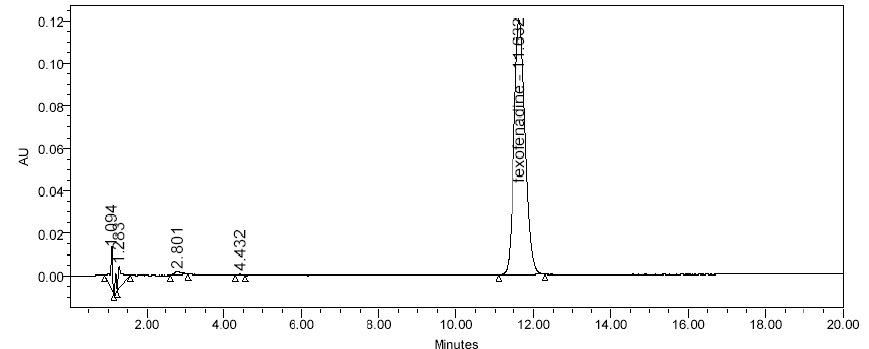
Figure 4. Chromatogram of acid-treated fexofenadine. Chromatogram of acid (1 N HCl) hydrolyzed fexofenadine at 80 o for 1 h showing degradation peaks at retention time (T ) 1.283 min, 2.801 min, 4.432 min. R